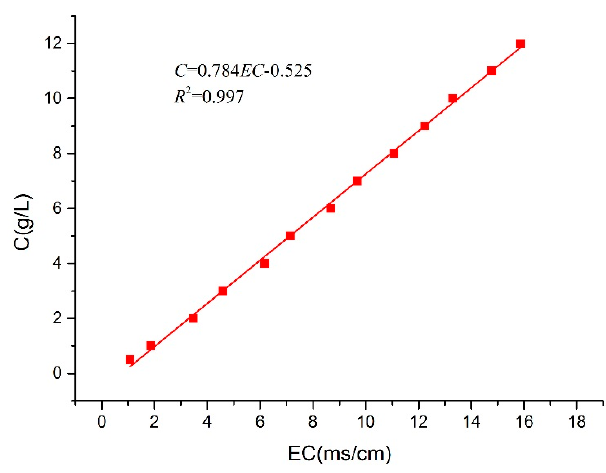
Figure 5. Relationship between the concentration and EC values.